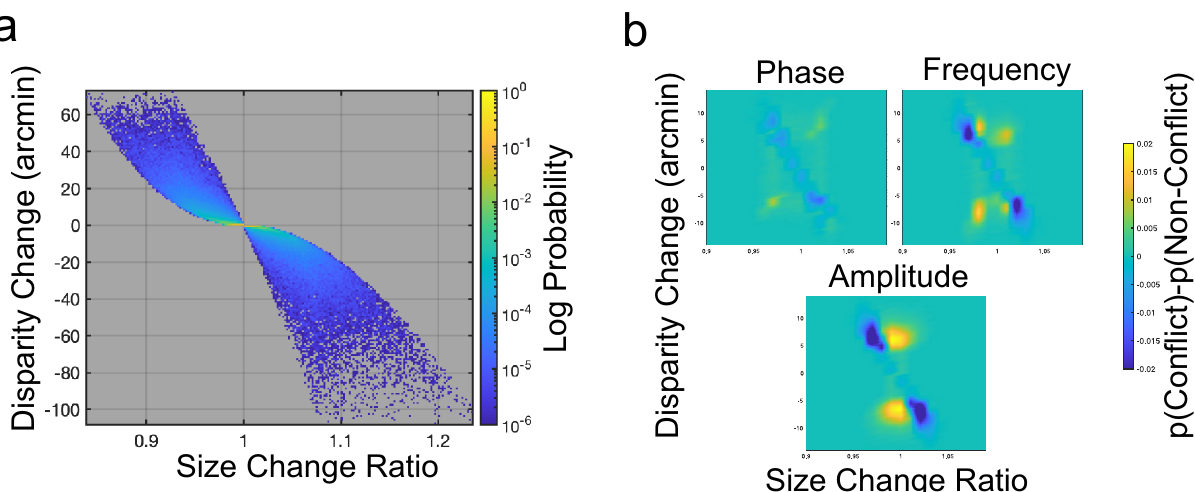
Figure 4. Cue Co-occurrence statistics for changing size and changing disparity ( a ). To model cue conflict discrimination, we considered the probability of co-occurrence of CD and CS cues, the distribution for which is shown here. ( b ) Comparison of cue co-occurrence for consistent cue and threshold conflict stimuli. Blue areas show combinations of CD and CS signals that are less likely to occur in threshold conflicts than in consistent cue stimuli. Yellow areas show combinations of cues that are more likely to occur under such conditions. For threshold-level conflicts, there was an increase in otherwise unlikely combinations of CD and CS, and a reduction in typically more likely